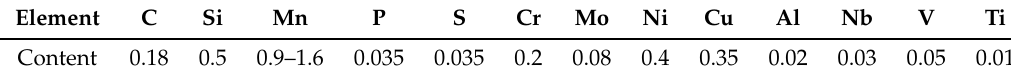
Table 1. Typical chemical composition of NVE36 (wt.%) [33].